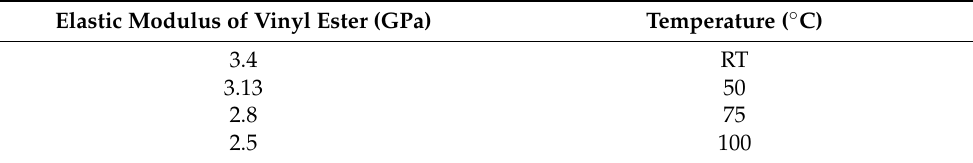
Table 2. Modules of vinyl-ester at different temperatures [28].